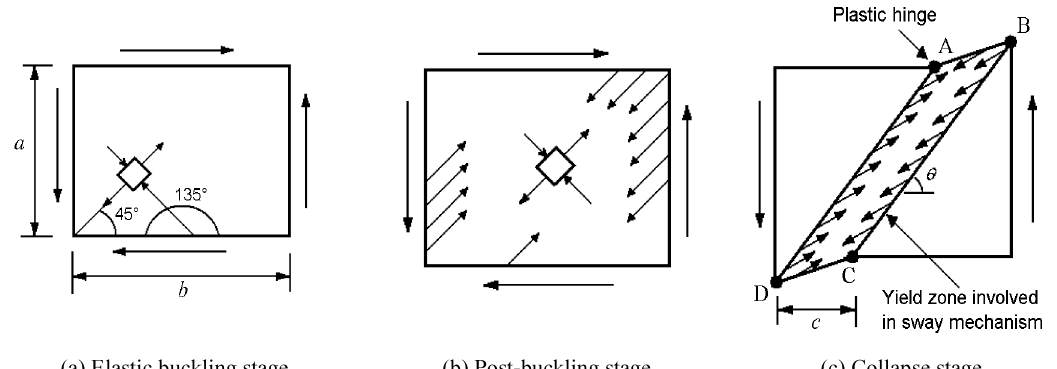
Fig. 1. Three stages in the collapse behaviour of plate girder